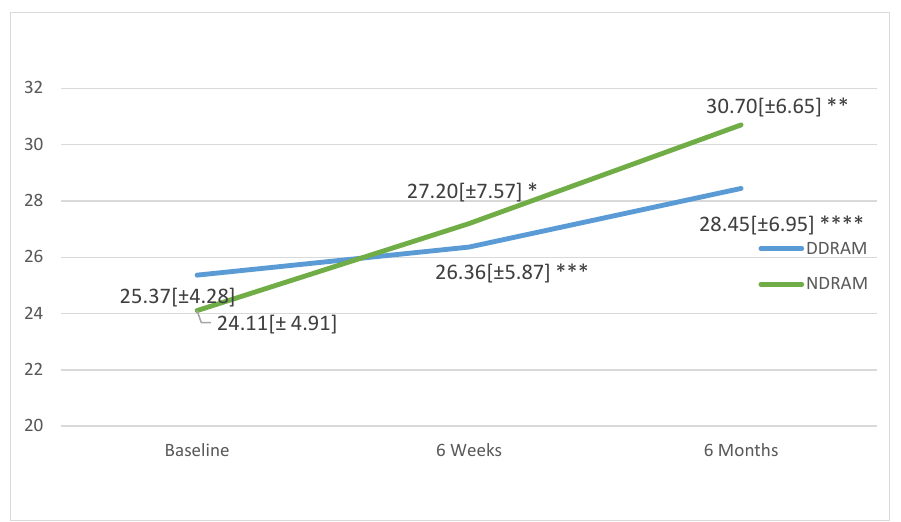
Figure 3. Change in physical health as measured with the Short Form 12 Health Survey (SF-12) in patients in each study group throughout the follow-up . Values expressed in means and standard deviations. p -values calculated with paired Student’s t -test. * p = 0.031, ** p = 0.003, *** p = 0.620, **** p = 0.263.